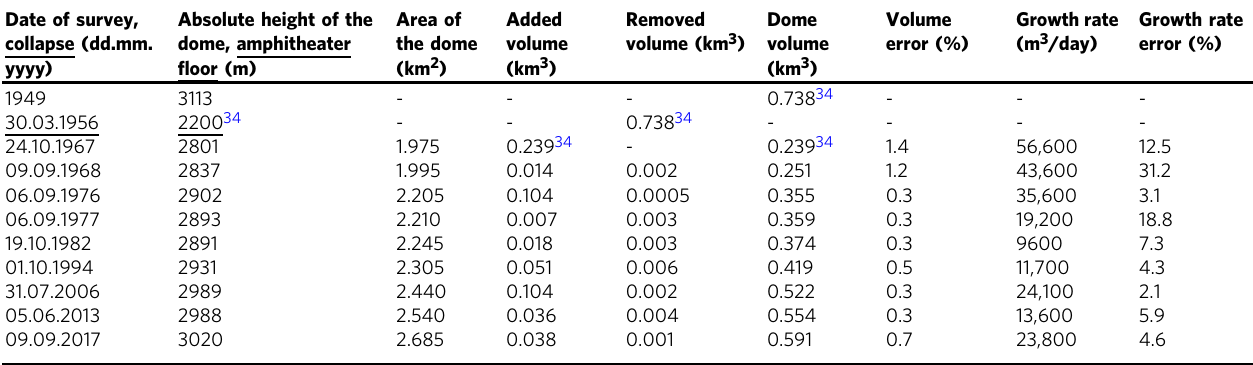
Table 1 Bezymianny dome parameters. Date of survey, collapse